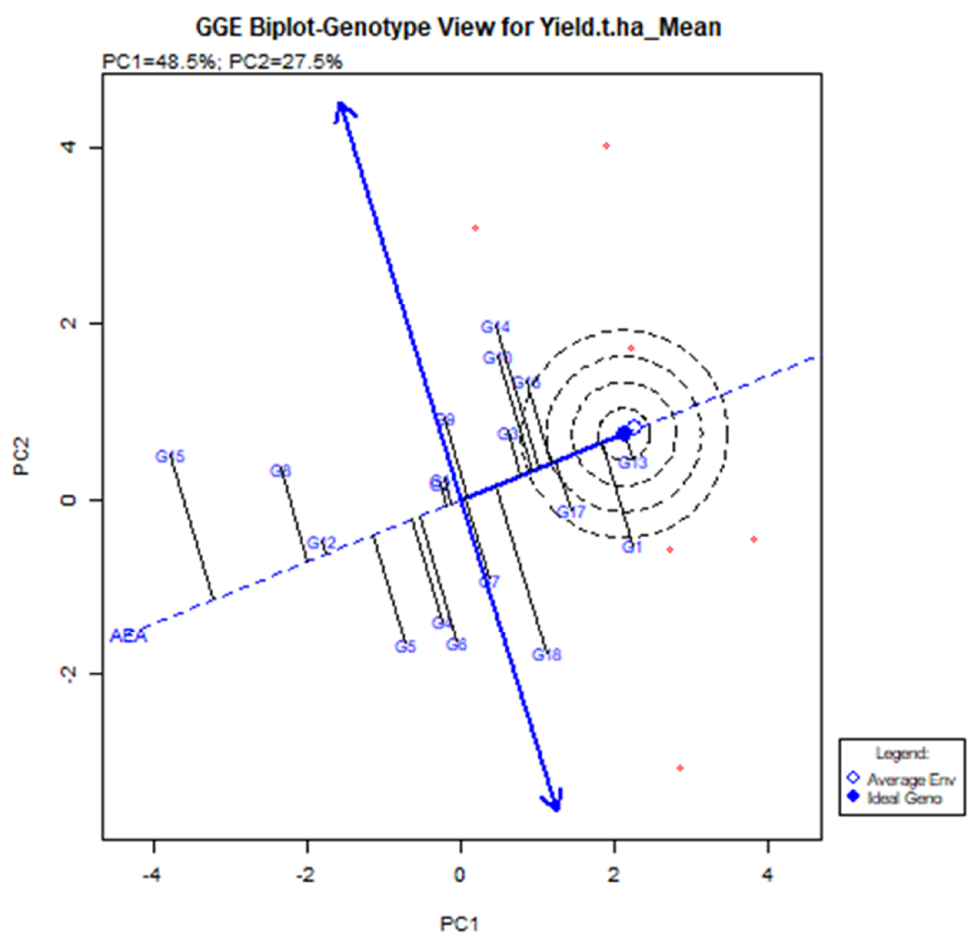
Figure 6. The mean and stability of elite rice genotypes for yield and definite genotype-environment interrelations during two consecutive seasons.